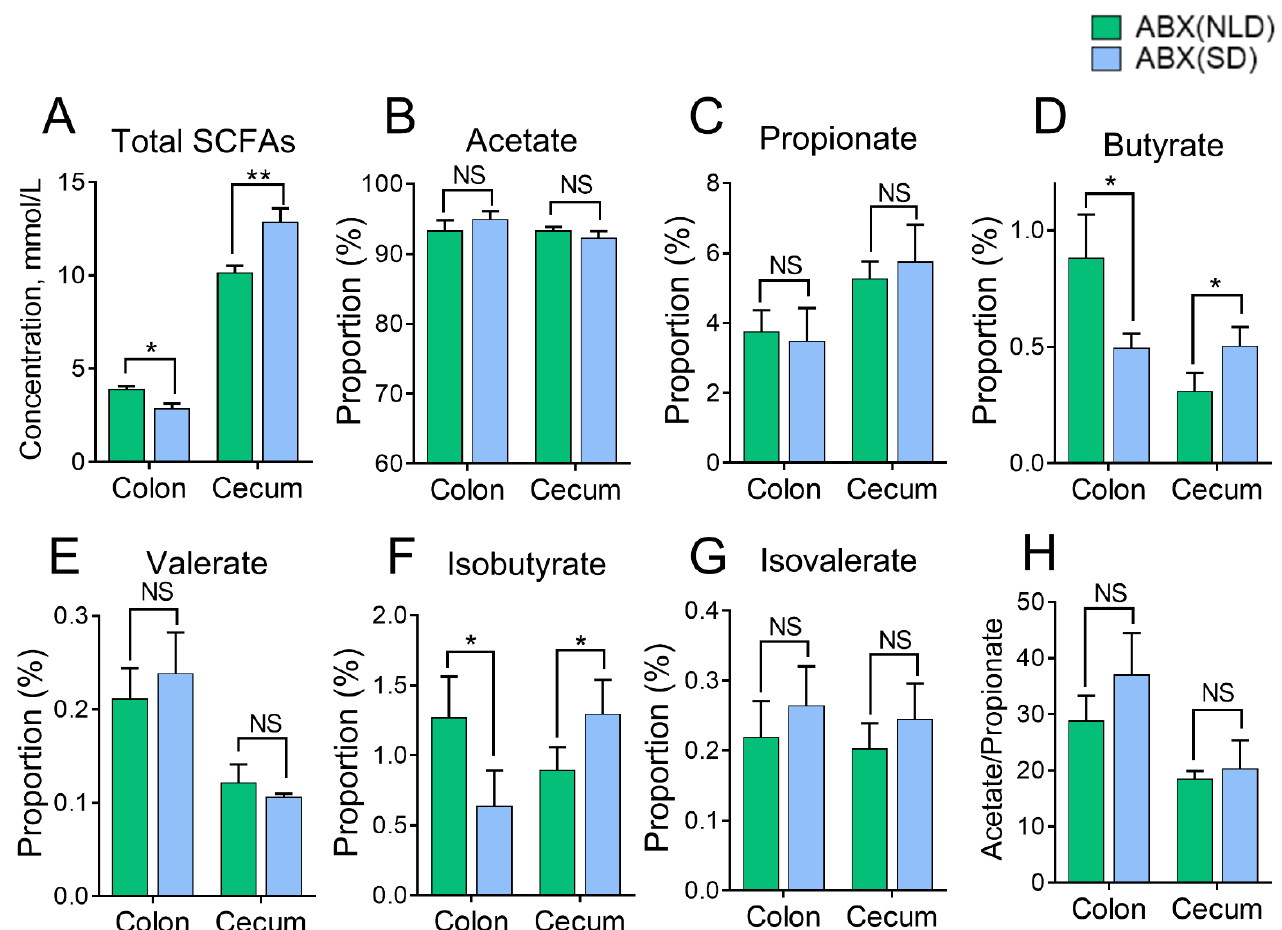
Figure 4. The proportions of SCFAs in colonic and cecal contents of ABX mice under NLD and SD. ABX (NLD), the antibiotic-treated mice managed under normal light–dark cycle; ABX (SD), the antibiotic-treated mice managed under short-day cycle. Representative charts of the concentration of total SCFAs ( A ), and the proportion of acetate ( B ), propionate ( C ), butyrate ( D ), valerate ( E ), isobutyrate ( F ), isovalerate ( G ), and the ratio of acetate to propionate ( H ) were determined in ABX mice under NLD and SD. Values were means, with standard error of the mean. * p < 0.05, ** p < 0.01, NS p > 0.05.